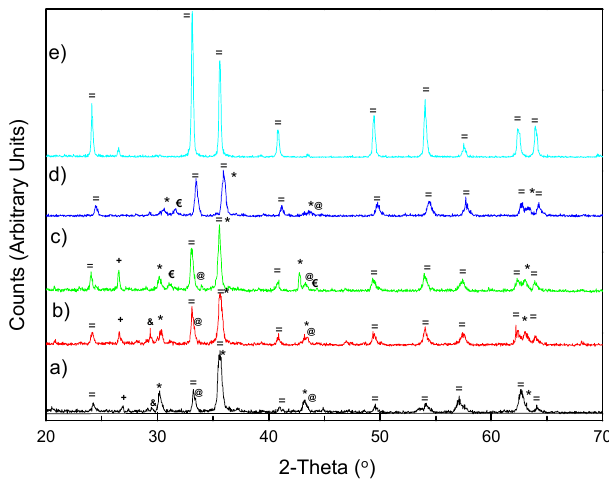
Figure 1. XRD patterns of (a) HSL, (b) HSL600, (c) HSL750, (d) HSL900 and (e) α -Fe 2 O 3 samples. (+: SiO 2 ; €: CaFe 2 O 4 ; @: (Fe 0.6 Cr 0.4 ) 2 O 3 ; &: CaCO 3 ;*: γ -Fe 2 O 3 /Fe 3 O 4 ; =: α -Fe 2 O 3 ) The analysis of the particle size of HSL shows an asymmetrical bimodal distribution, with particles in the 0.2–140 µ m size range, Figure 2a. The majority of the particles displayed particle sizes lower than 20 µ m. Another significant number of particles exhibited sizes between 30 and 150 µ m. This distribution was confirmed by electron microscopy. The particles corresponding to both fractions of size can be observed in Figure 2b.